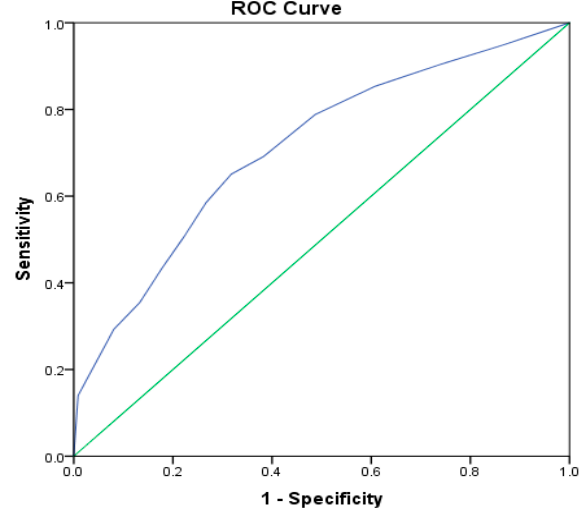
Figure 9. ROC curve for the model of plant damage occurrence in binomial regression.